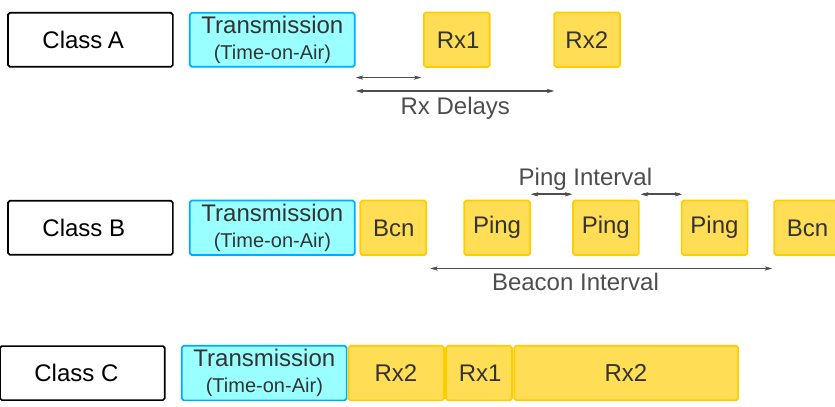
Figure 3. LoRaWAN